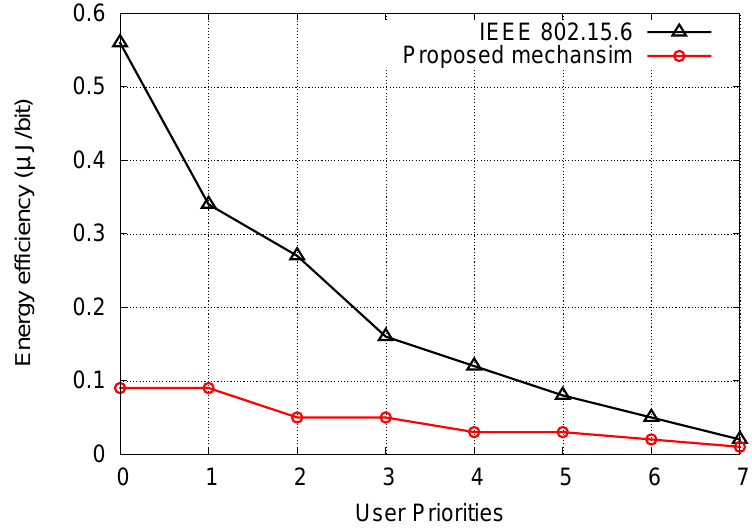
Figure 6. Energy efficiency comparison of IEEE 802.15.6 and proposed mechanism for different UP (Scenario